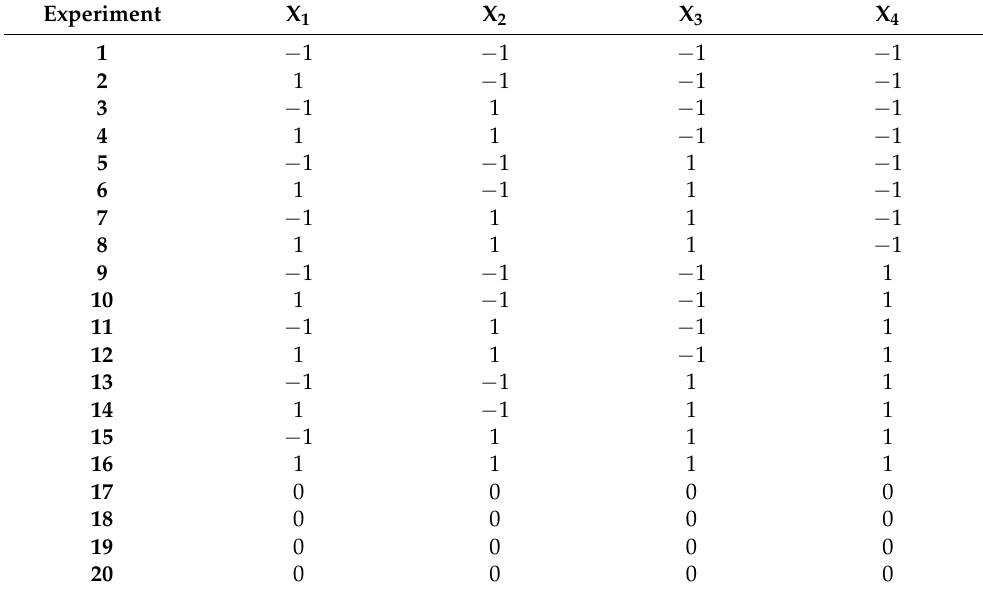
Magnetite nanoparticles (mg/X 4 ) Table 2. Complete factorial planning